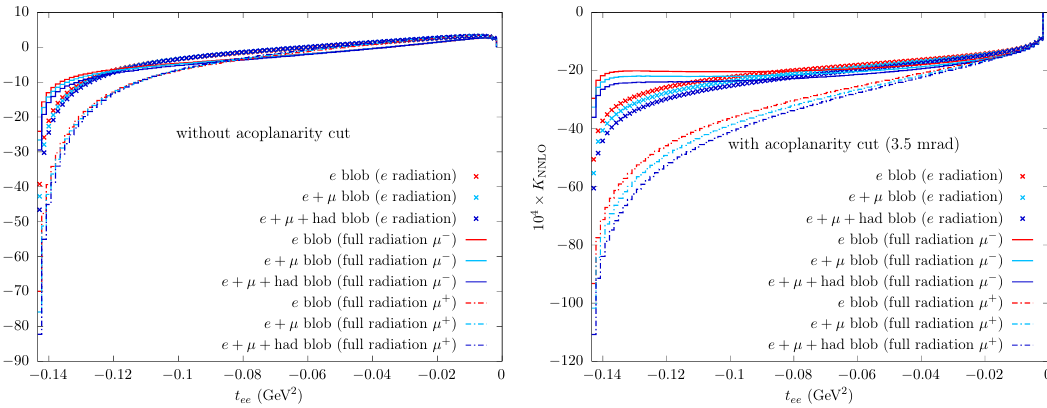
Figure 15. Left: differential K NNLO factor on t ee distribution, including the complete set of NNLO virtual leptonic pair corrections. Right: the same observable including the acoplanarity